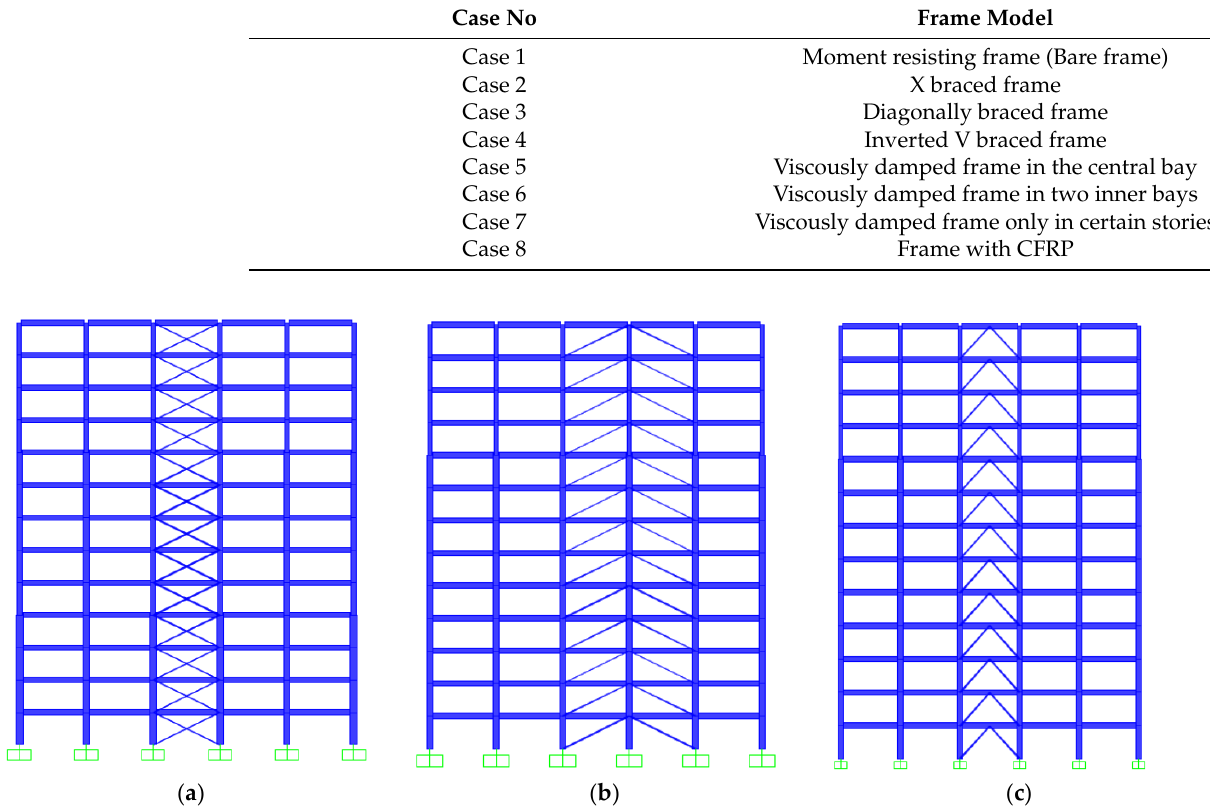
( c ) Figure 4. ( a ) Viscously damped frame in the central bay, ( b ) viscously damped frame in two inner bays, and ( c ) Viscously damped frame only in certain stories. In the studied structure, the effect of viscous damping with 15% damping has been investigated. To determine the required damping of the structure to reach the damping percentage of the target, the stiffness of the whole structure should be determined [26]. First, the triangular pattern of the base shear force and the level of drifts of each story are calculated. Then, with the help of the sheer force of each story and the corresponding drift with the same shear force, the shear stiffness of each story can be obtained. Finally, the total damping coefficient that must be added to the structure to achieve the target damp- ing can be calculated [27]. In the case of the frames upgraded with carbon fiber reinforcement polymer (CFRP), the CFRP is assumed to be warped around the two sides and bottom of beams. The ulti- mate strength is 3200 MPa, in the longitudinal direction of fibers, and the elastic modulus is 210,000 MPa. The thickness of the CFRP wrap is 1.4 mm. An investigation of the